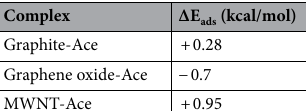
Table 1. Graphene oxide, graphite, and multi-walled nanotubes docking energies.